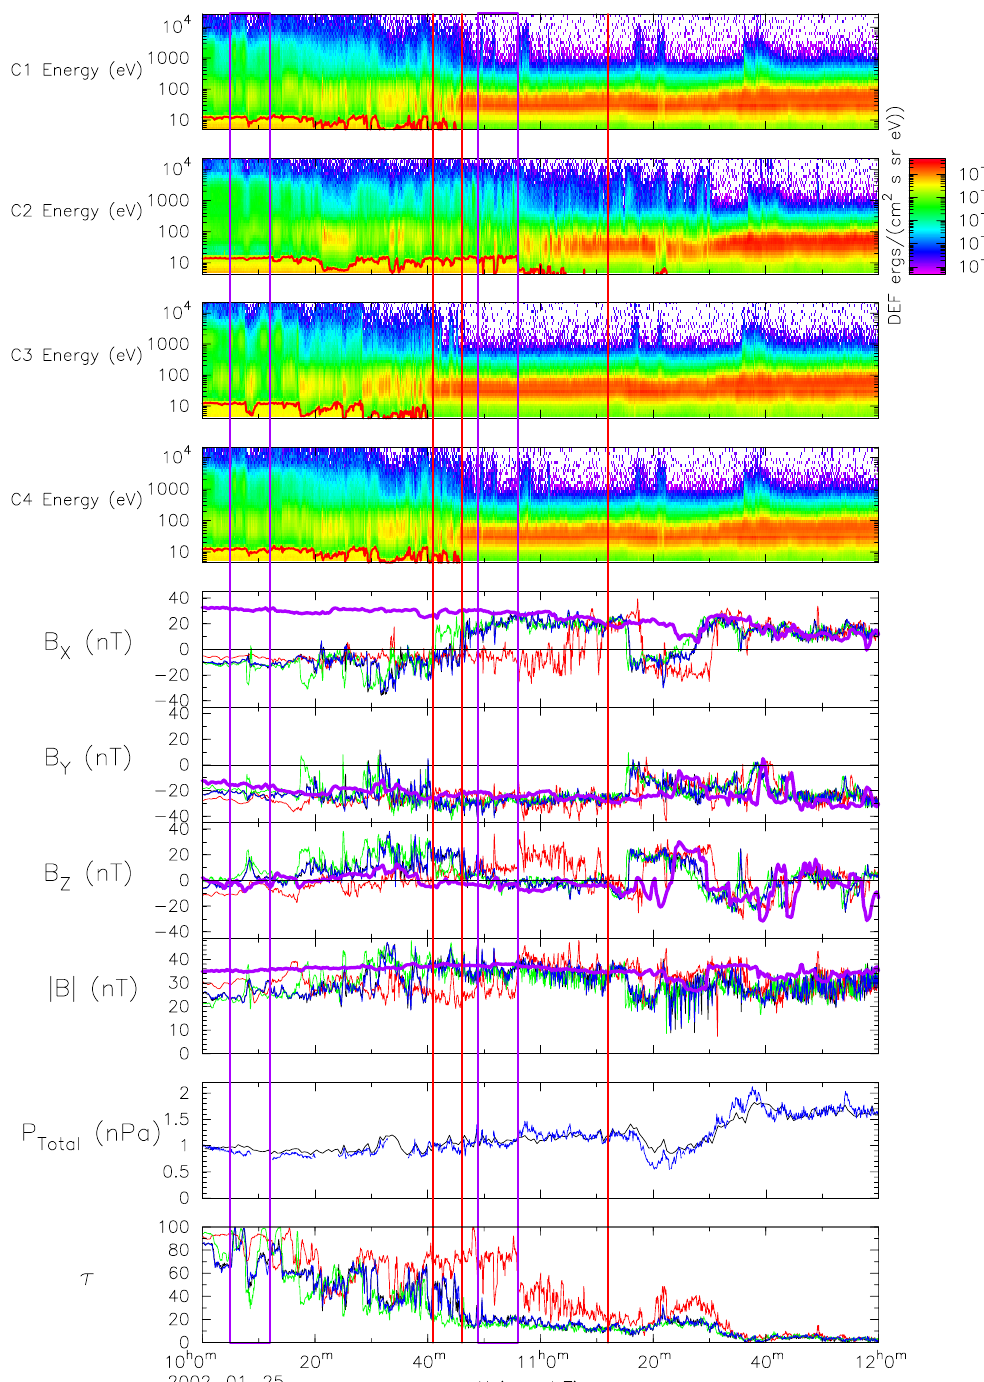
Fig. 2. An overview of the PEACE and FGM data and the interplanetary magnetic field (IMF). The top four panels are spectrograms of the omnidirectional electron differential energy flux observed by the PEACE instruments on Clusters 1, 2, 3 and 4. The next four panels show the magnetic field observed by FGM on Clusters 1, 2, 3 and 4 in black, red, green and blue respectively in GSE coordinates. The magnetic field observed by ACE, lagged by 75min and multiplied by a factor of 4, is over-plotted in magenta. The penultimate panel is the total pressure observed at Clusters 1 and 4 (calculated from the magnetic pressure and the thermal pressure derived from on-board CODIF moments corrected for dead-time effects). The bottom panel shows the magnetopause transition parameter calculated from the PEACE on-board moments. The magnetopause crossings made by Clusters 3, 1 and 4, and 2 are shown by red lines at 10:41, 10:46 and 11:12 UT respectively, and the events analysed at 10:08 and 10:52 UT are indicated by magenta